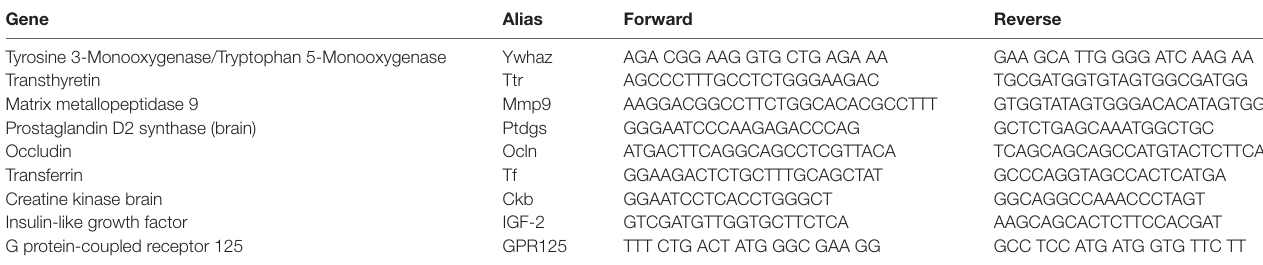
TABLE 1 | Quantitative transcription-polymerase chain reaction (RT-PCR) mouse primers. Gene